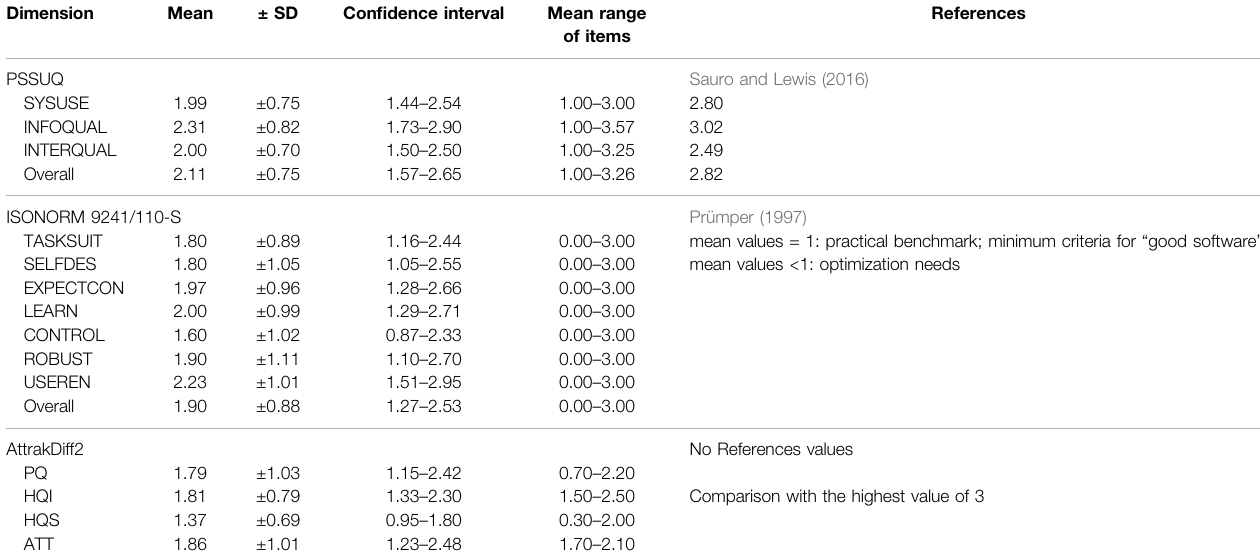
TABLE 3 | Results on usability based on PSSUQ, ISONORM 9241/110-S, and AttrakDiff2. Dimension